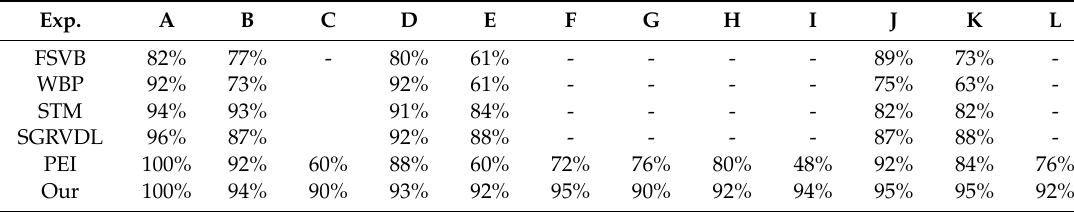
Table 2. Recognition results on the Mobo data